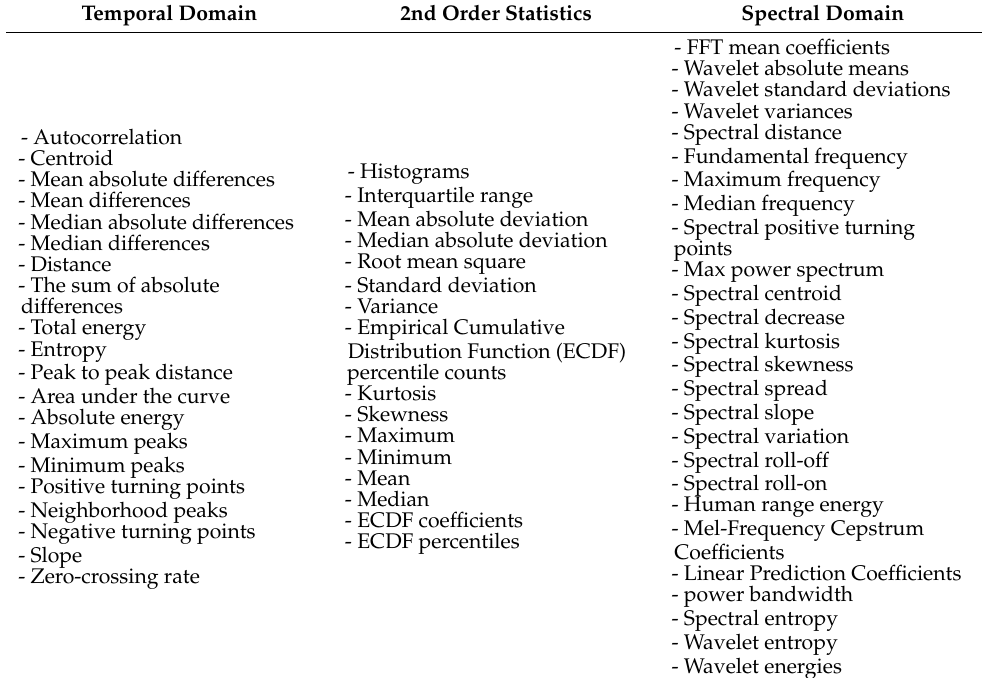
Table 1. Features from different